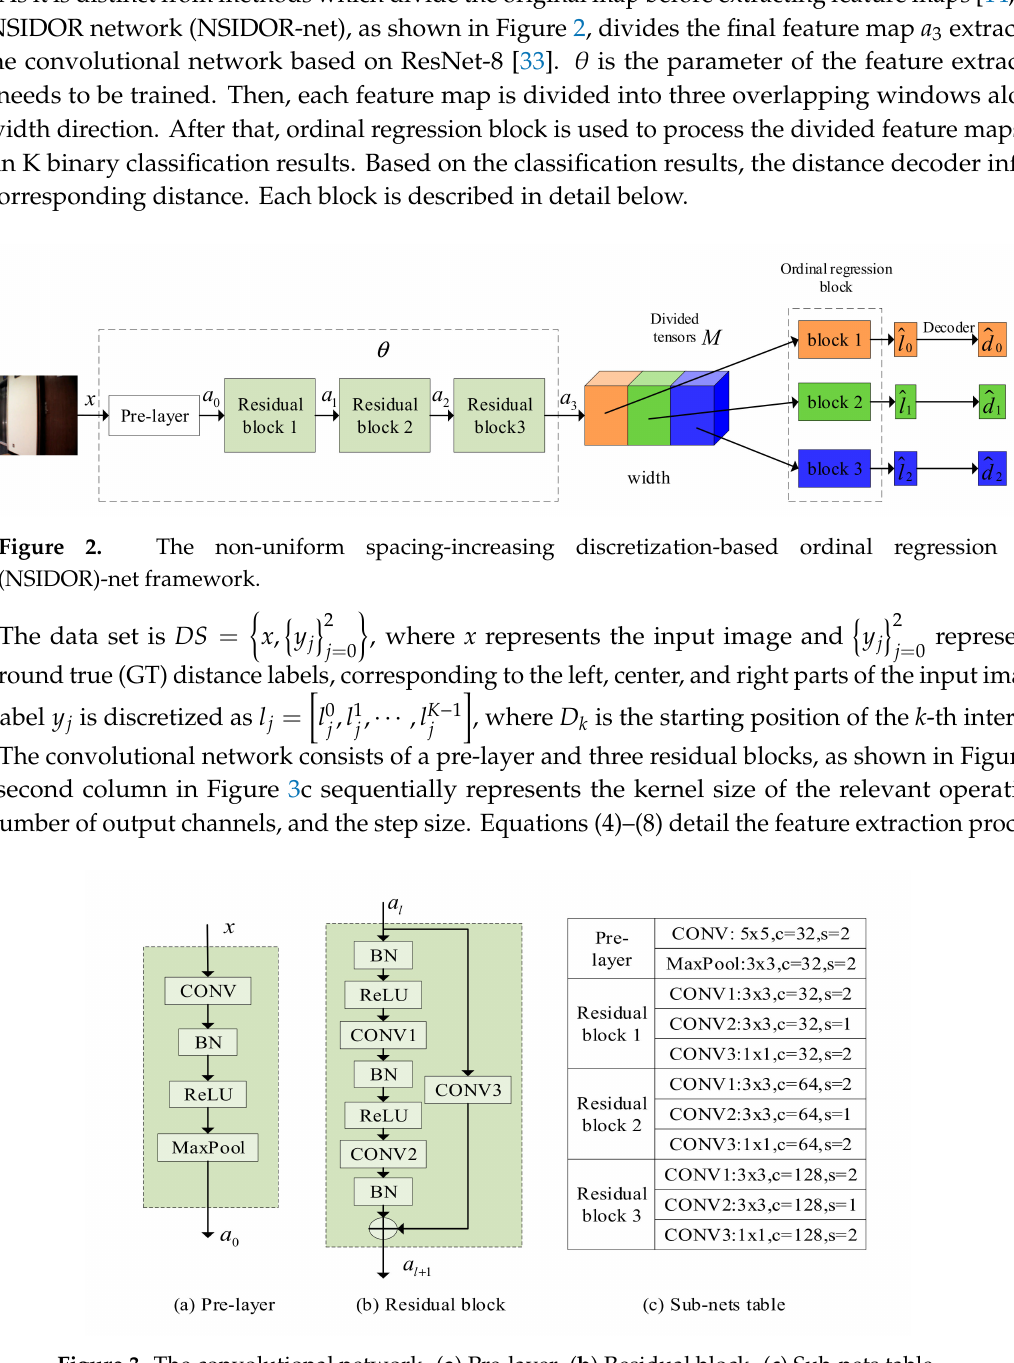
Figure 3. The convolutional network. ( a ) Pre-layer. ( b ) Residual block. ( c ) Sub-nets